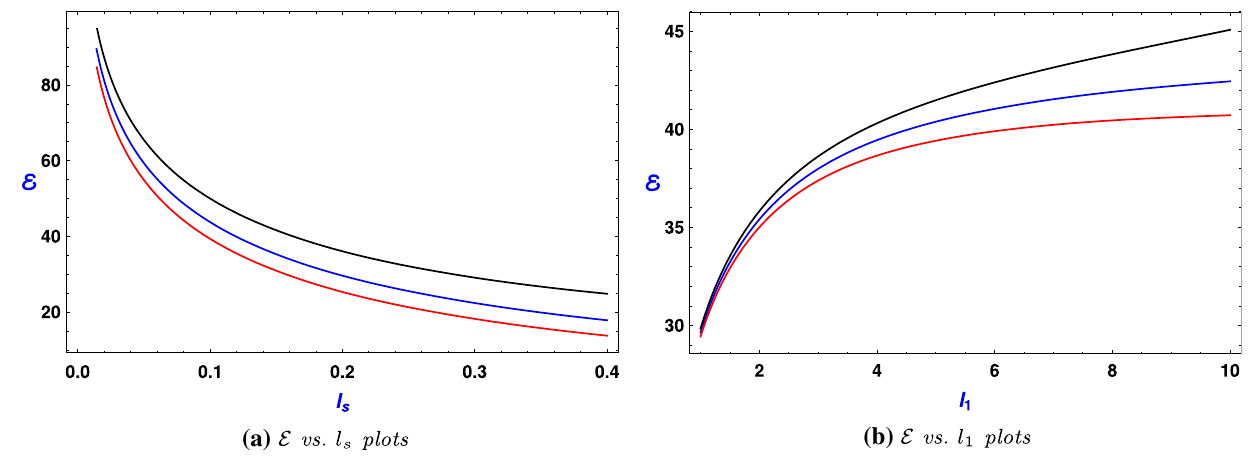
Fig. 2 Negativity plots for two disjoint intervals in a CFT 1 + 1 in different cases. In both the figures, the blue, black and red curves represent the vacuum scenario, finite size system and finite temper- ature system, respectively. a shows plots of negativity vs. separation